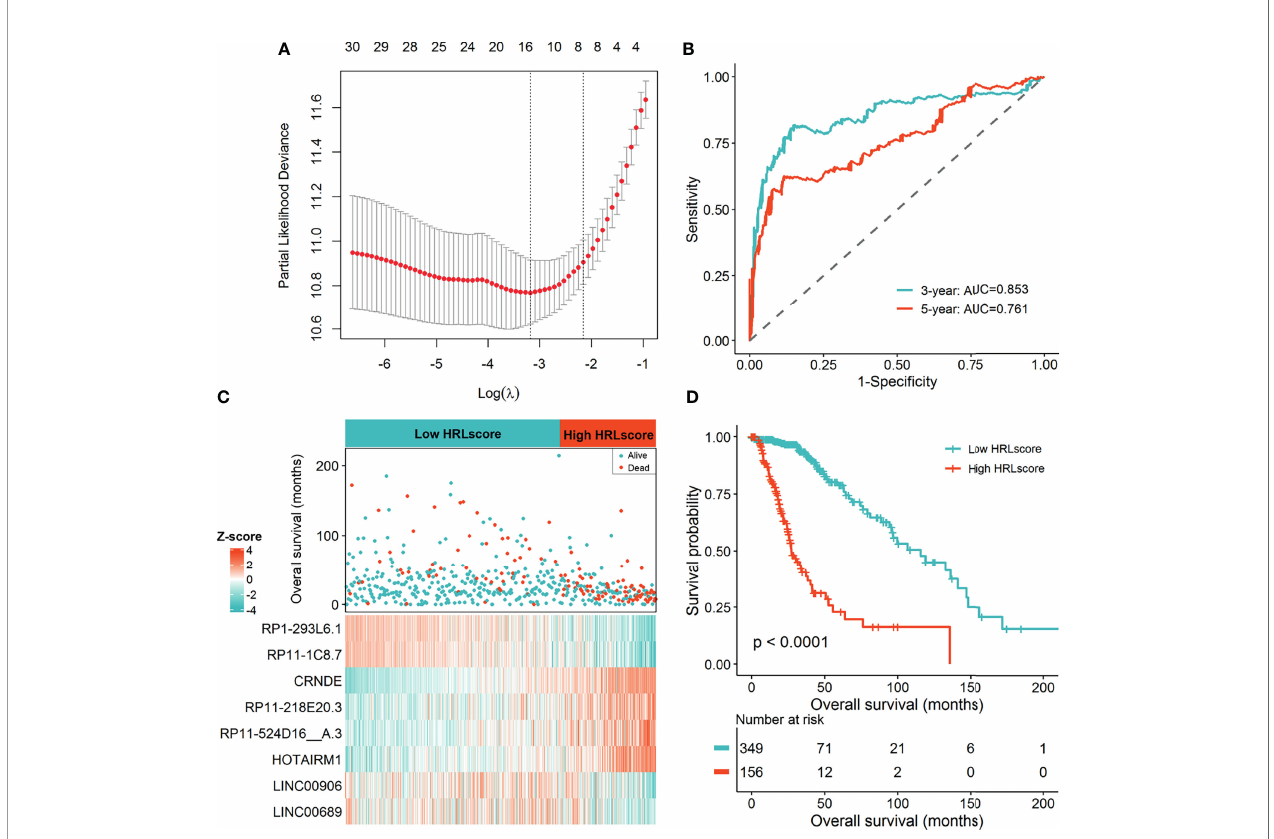
FIGURE 2 | Derivation of the HRL signature in the TCGA-LGG cohort. (A) LASSO regression analysis with 10 cross-fold validation. (B) Time-dependent ROC curves for evaluating the prognostic performance. (C) Distribution of overall survival and expression of the eight informative HRLs between high- and low-HRLscore groups. (D) Survival curves for patients with different